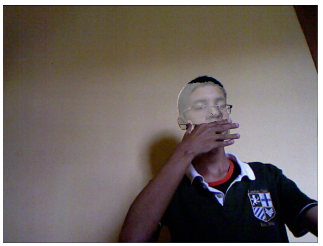
Fig. 6. An example of tracking failure. The user needs to reposition his face to the tracking algorithm align correctly the raw depth data to the reference 3D model.